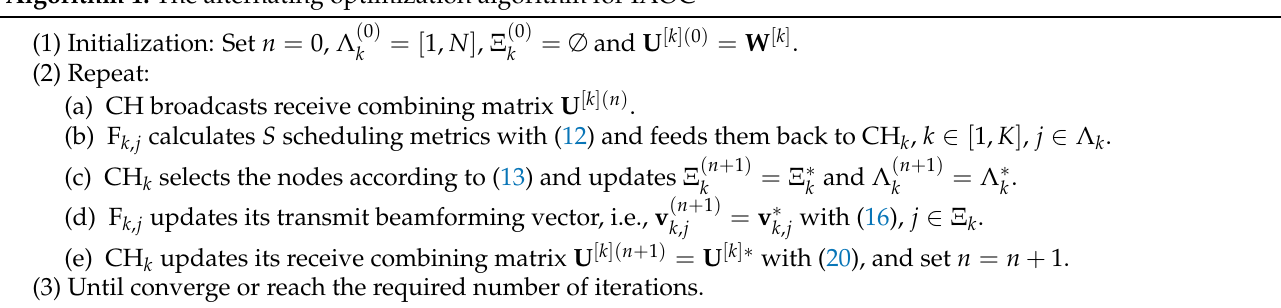
Algorithm 1: The alternating optimization algorithm for